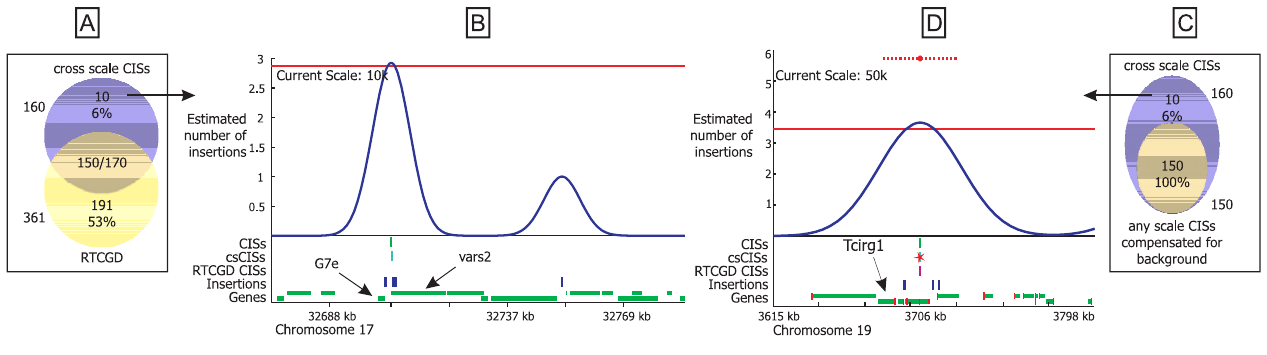
Figure 8. Example of Novel CIS and Background Corrected CIS (A) Venn diagram comparing the csCISs and the CISs in the RTCGD. For reasons explained in Figure 7, the intersection shows two counts. (B) An example of a CIS that consists of three insertions from three independent screens, and therefore is only detected when integrally analyzing the data. (C) Venn diagram comparing the csCISs with and without applying background correction. (D) An example of a csCIS, that was also included in the RTCGD, and is rejected based on the background-corrected threshold. The small vertical bars (red) in the genes denote the 5 9 ends of genes, and a star denotes a corrected CIS. Since we are only interested in correcting regions that are putative CISs, a background-corrected threshold is only computed for peaks in the estimated number of insertions. The corrected threshold is given by the horizontal dotted line above the peak. doi:10.1371/journal.pcbi.0020166.g008 PLoS Computational Biology |